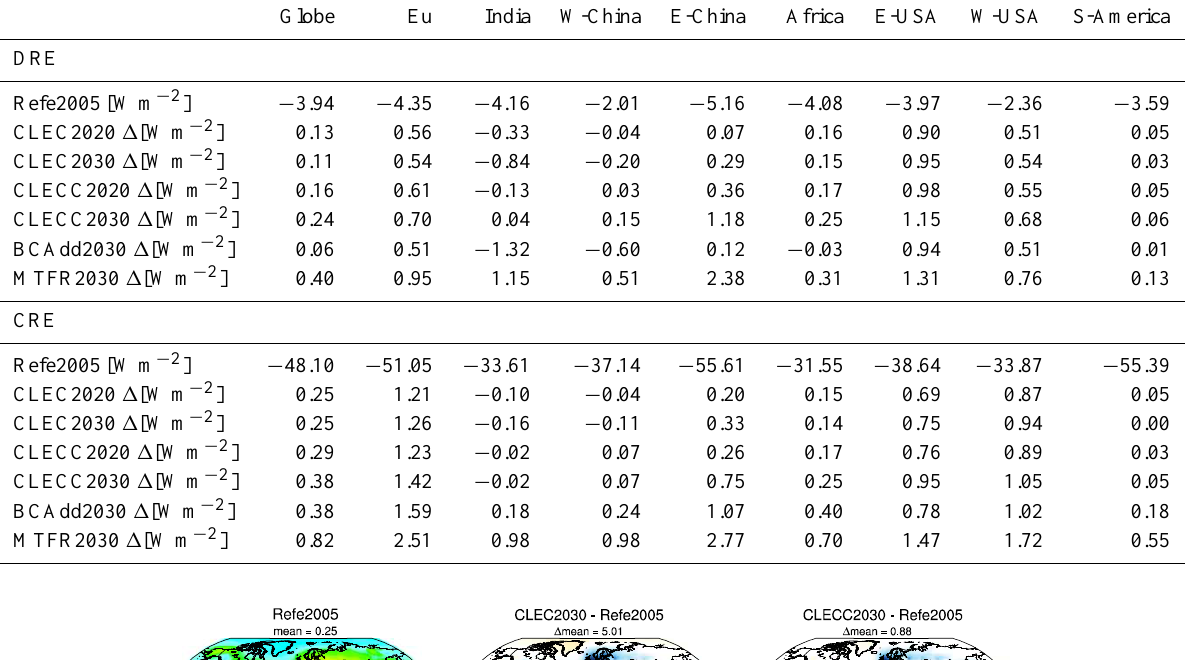
Table 3. The global and regional mean clear-sky direct radiative effect (DRE) and cloud radiative effect (CRE) at the top of the atmosphere for the reference simulation and the changes in these (i.e. changes in aerosol radiative forcing) from the reference simulation to the future in different emission scenarios.